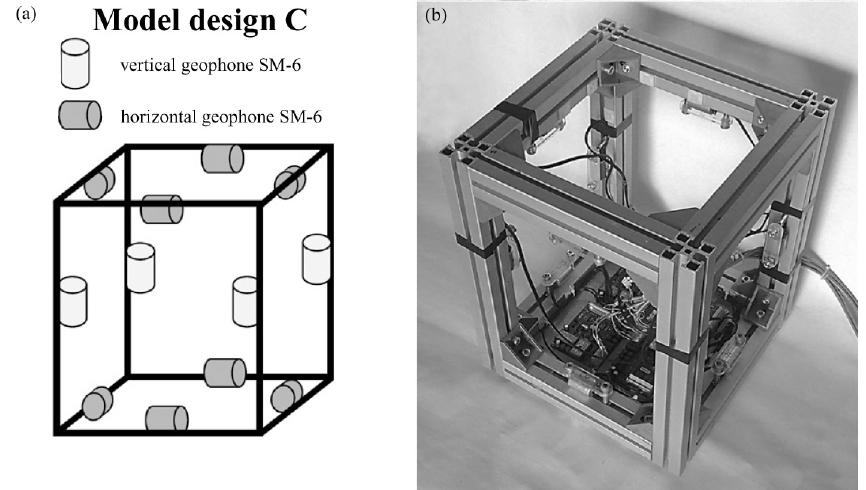
Figure 4. Rotaphone-C: scheme of geophone pairs ( a ) and photograph ( b